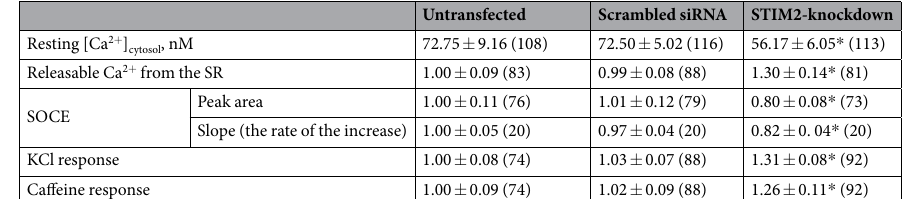
Table 4. Properties of the STIM2-knockdown mouse primary skeletal myotubes. The values, except for those of the cytosolic Ca 2 + levels at rest, were normalized to the mean value of those from the untransfected controls. The values are presented as the mean ± S.E. for the number of myotubes shown in parentheses. * Significant difference compared with the untransfected control ( p < 0.05).